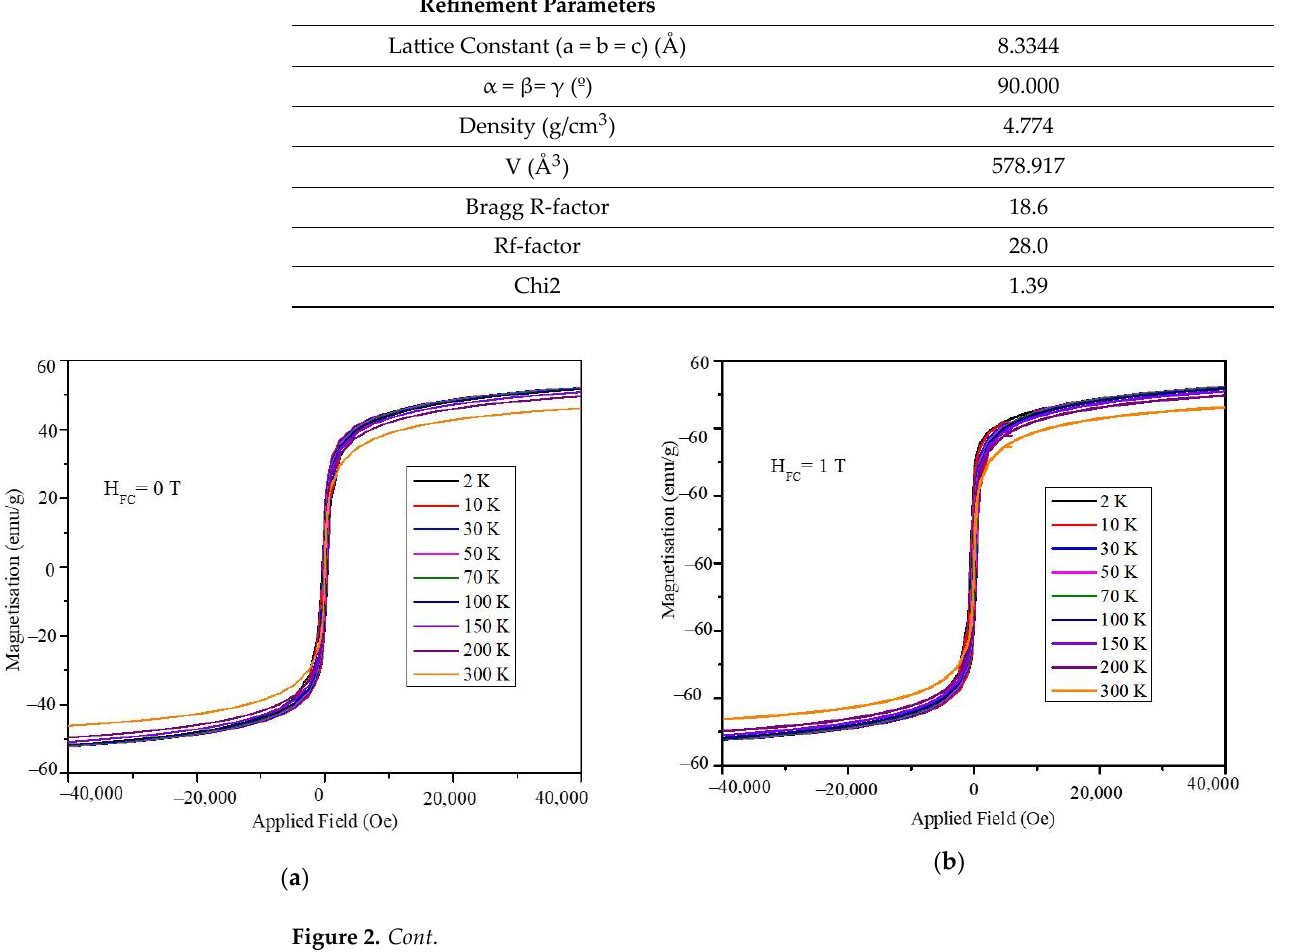
( f ) Figure 2. MH plots of the nanoparticles obtained under field cooling of ( a – e ) 0, 1, 2, 3, and 4 T. ( f ) Temperature-dependent saturation magnetization of maghemite nanoparticles under FC (0 – 4 T).